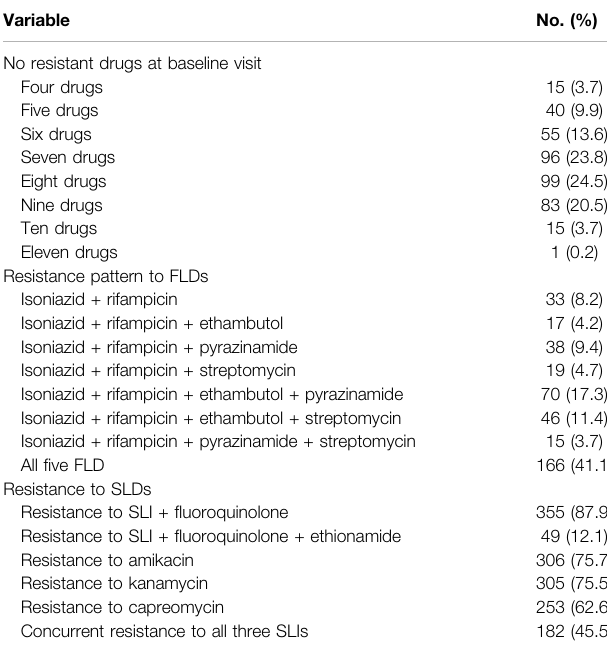
TABLE 2 | Drug resistance pattern of study